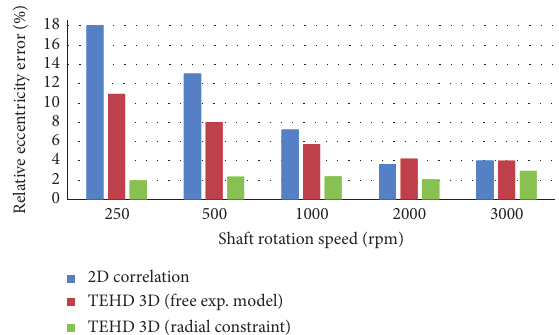
Figure 23: Difference between relative eccentricities measured and computed by means of most consistent 3D and 2D models for the modified RK in configuration